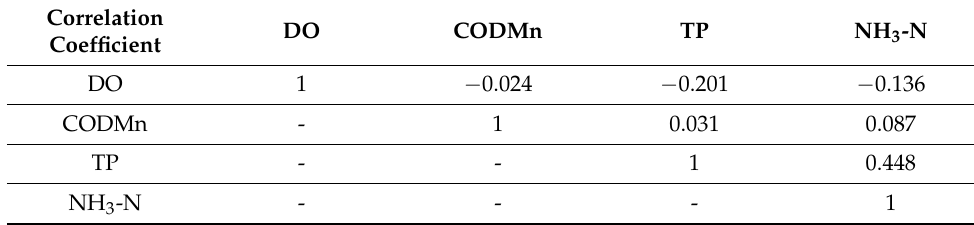
Table 3. Correlation coefficients for each